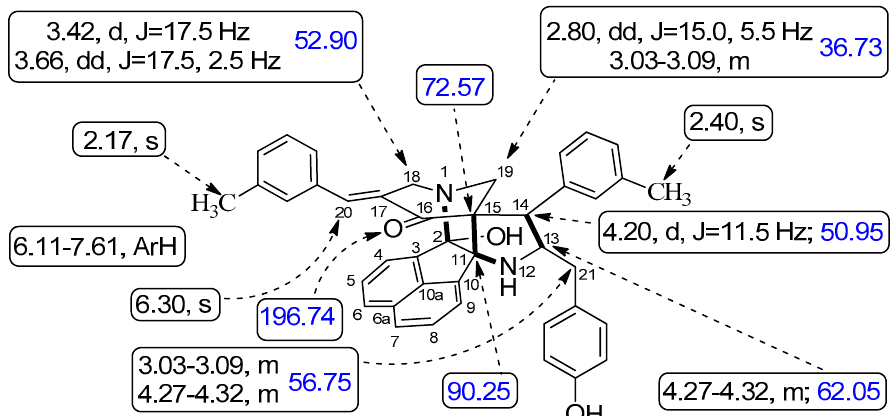
Figure 2. Arbitrary atom numbering and Selected 1 H- and 13 C-nuclear magnetic resonance (NMR) chemical shifts of 4b .